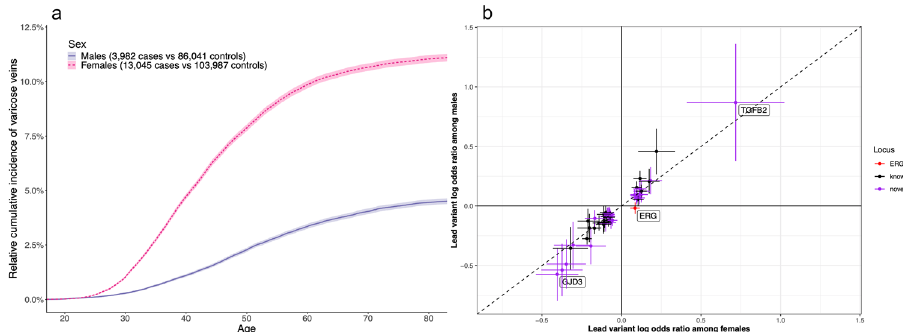
Fig. 2 Sex-based differences in the incidence and lead variants of VV in FinnGen. a The point estimates of the relative VV incidence in the FinnGen cohort as a function of age years for each sex are shown. The shadings around the incidence curves denote the 95% con fi dence intervals of the